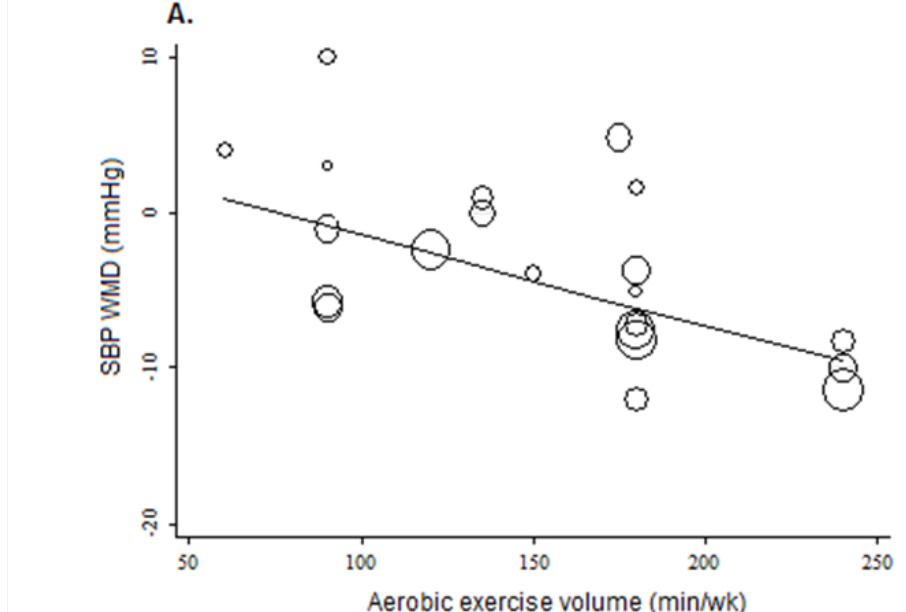
Figure F10-8. Dose-response Relationship between Aerobic Activity and Systolic Blood Pressure in Adults with Type 2